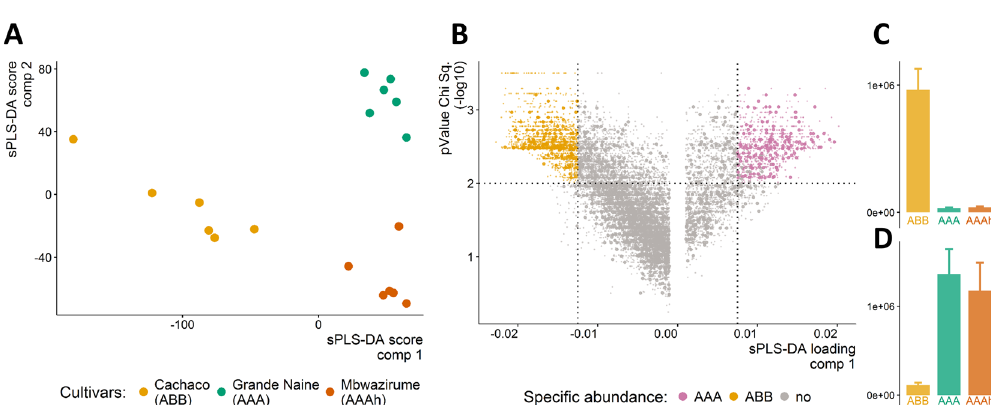
Figure 6. Quantitative selection of cultivar specific proteome features based on uni- and multivariate statistics. ( A ) Sparse partial least squares separates genomic groups (AAA and ABB) in Component 1. ( B ) Separation of features based on quantitative LC-MSMS. X-axis: sPLS-DA component 1: cut-off for selection <− 0.0125 and > 0.0075. Y-axis: − log10 of p-value of Chi Square Kruskal Wallis test with Benjamini-Hochberg p-value adjustment. P-value of 0.01 used as cutoff for Y axis. ( C , D ) Examples of ABB and AAA specific expression pattern